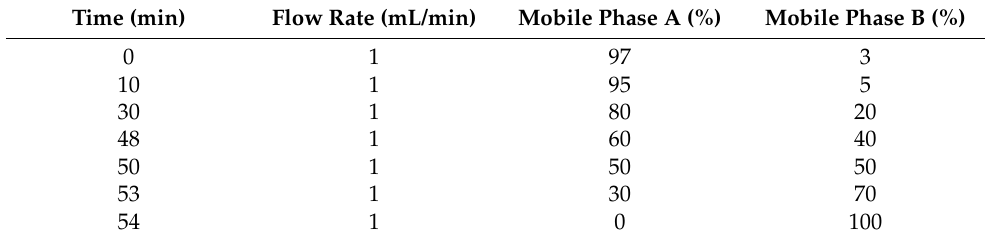
Table 1. Liquid chromatography elution gradient table of peptide fraction separation.